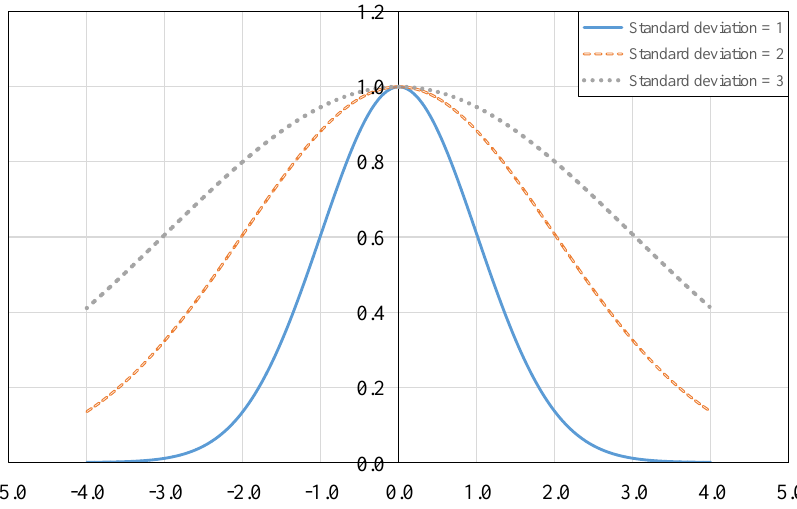
Figure 4. The change of Gaussian function curve with standard deviation.